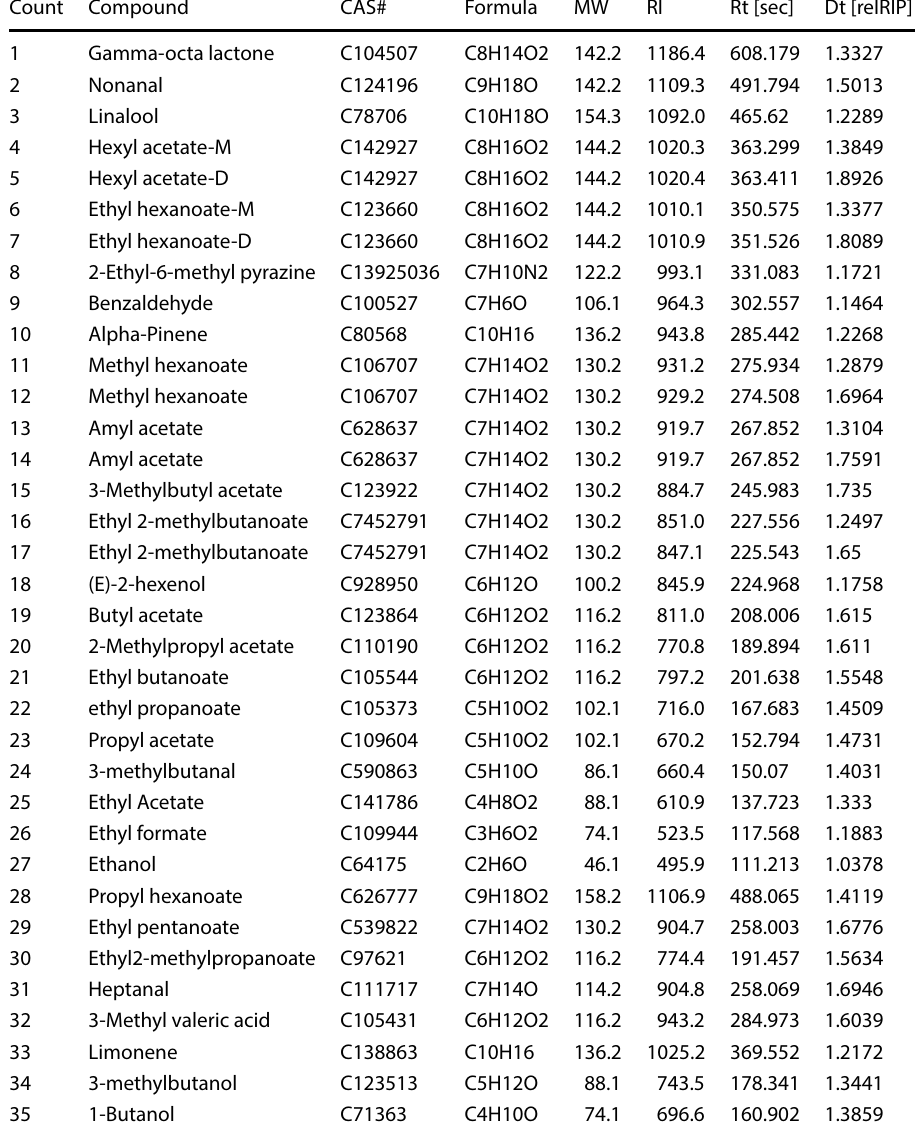
Table 1 Qualitative analysis of main volatile organic compounds in